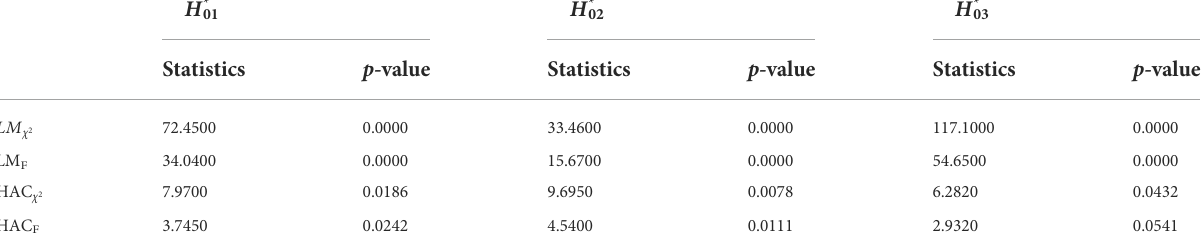
TABLE 4 Sequence of homogeneity tests.